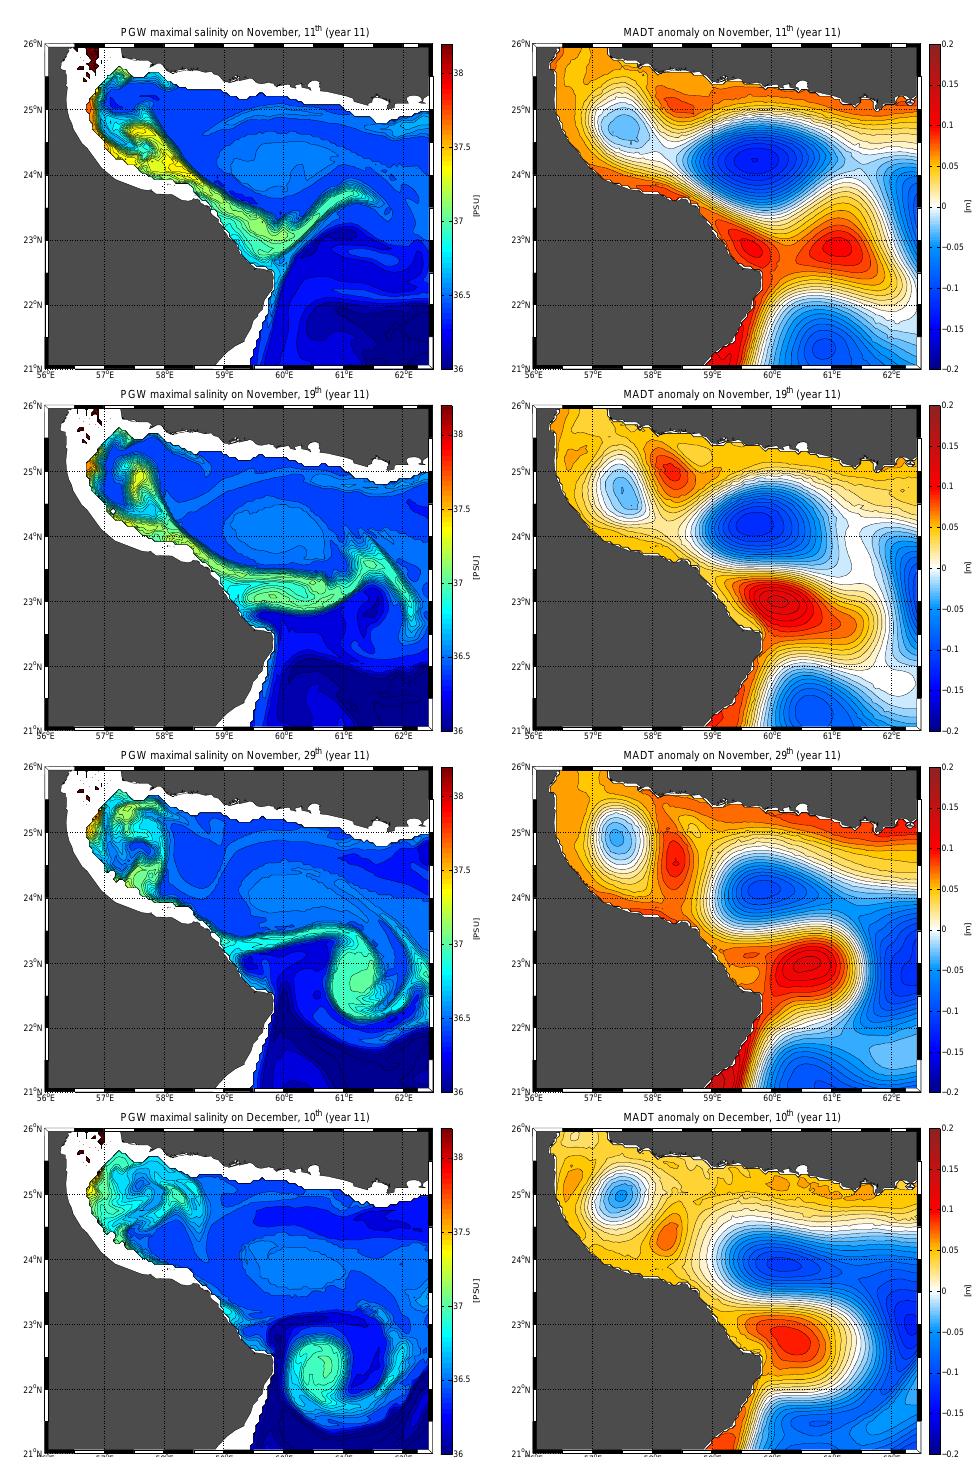
Figure 19. Evolution of the maximal PGW salinity (left) and MADT anomaly (right) during the formation of a lee eddy in year 11 of the HYCOM simulation, on 11 November (first row), 19 November (second row), 29 November (third row) and 10 December (fourth